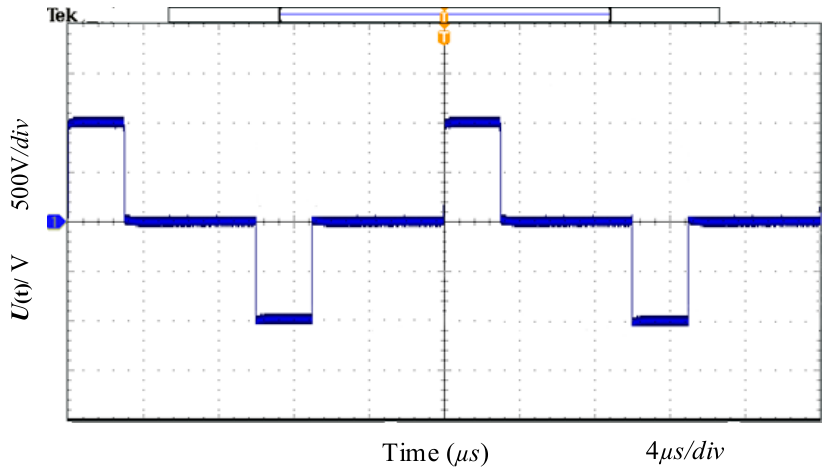
Figure 12. Experimental voltage waveform.